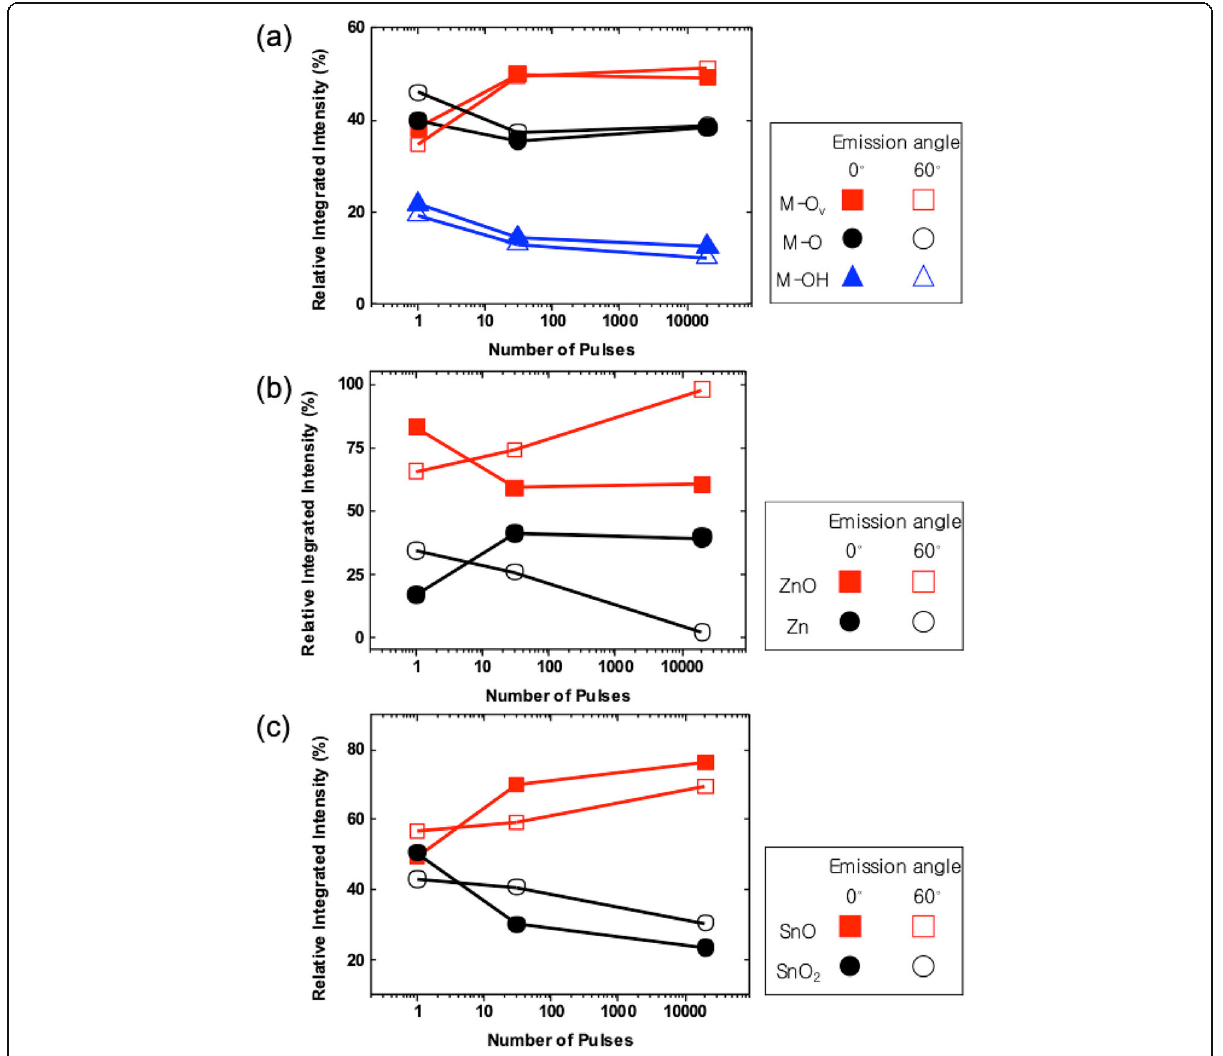
Fig. 4 The changes of chemical state of a O, b Zn, and c Sn in ZTO as a function of the number of laser